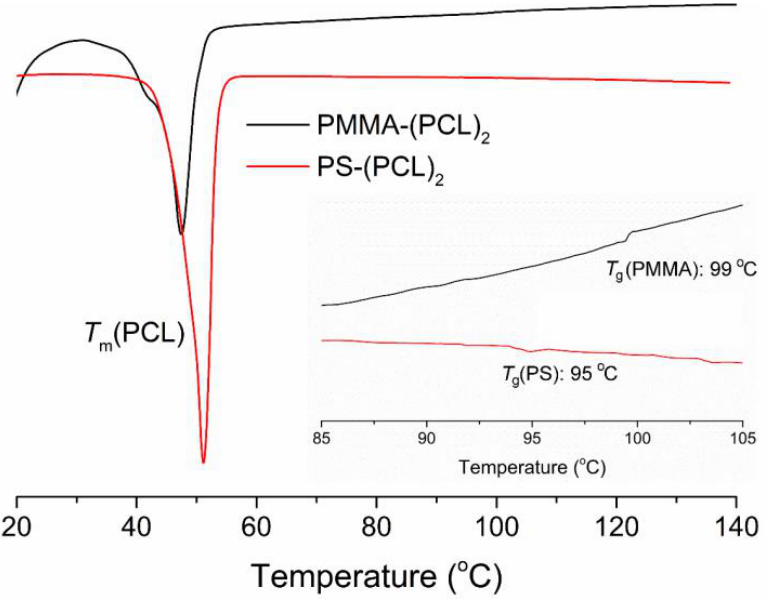
Figure 4. DSC thermograms of PMMA-(PCL) 2 and PS-(PCL) 2 star copolymers.